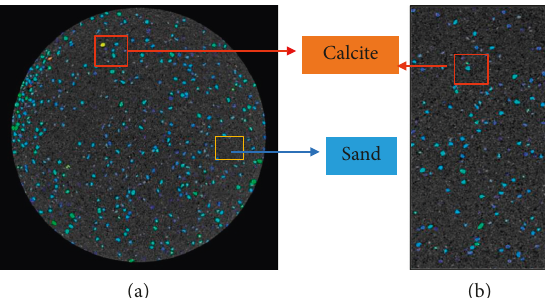
Figure 4: The micro-CT experimental result. (a) Cross Section. (b) Longitudinal section.